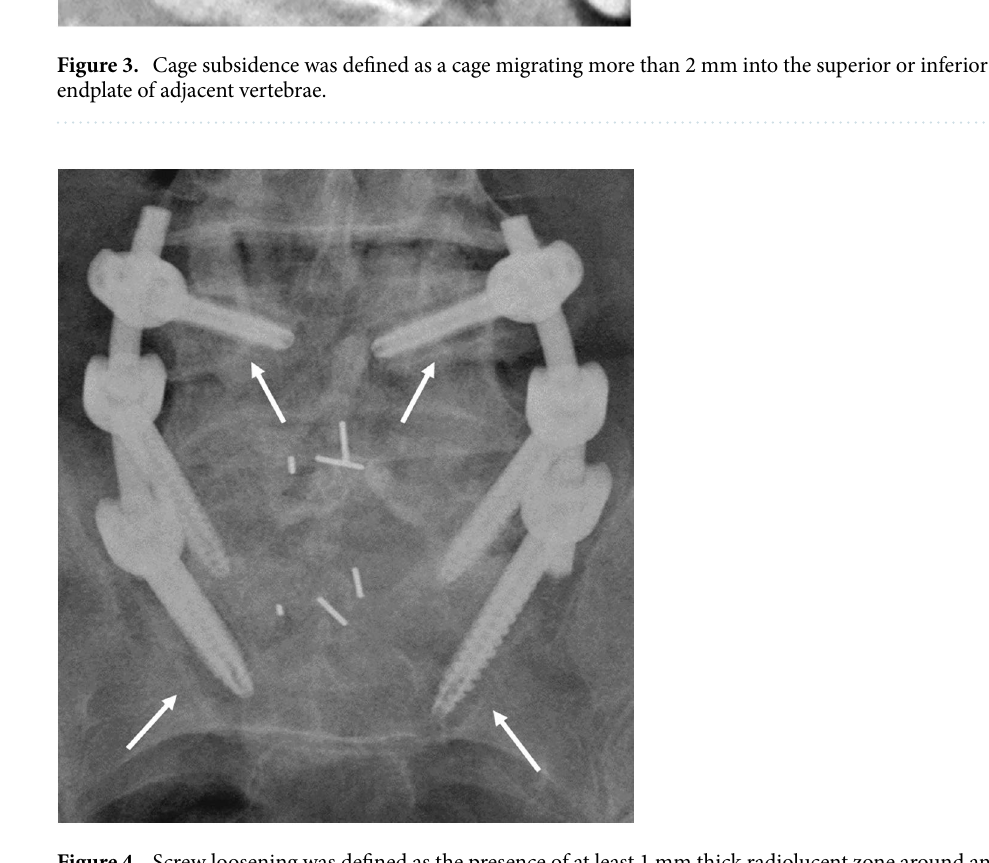
Figure 4. Screw loosening was defined as the presence of at least 1 mm thick radiolucent zone around any pedicle screw (Halo sign). Bilateral halo sign is evident on L3